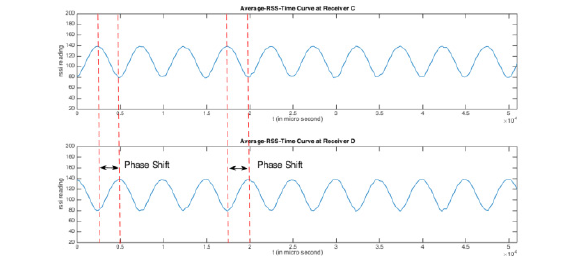
Fig. 9. Phase Offset of Average-RSS-Time Curves